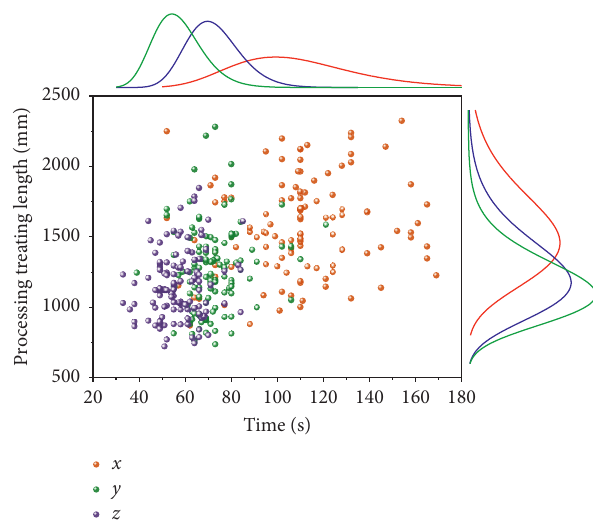
Figure 7: Processing information with a short time